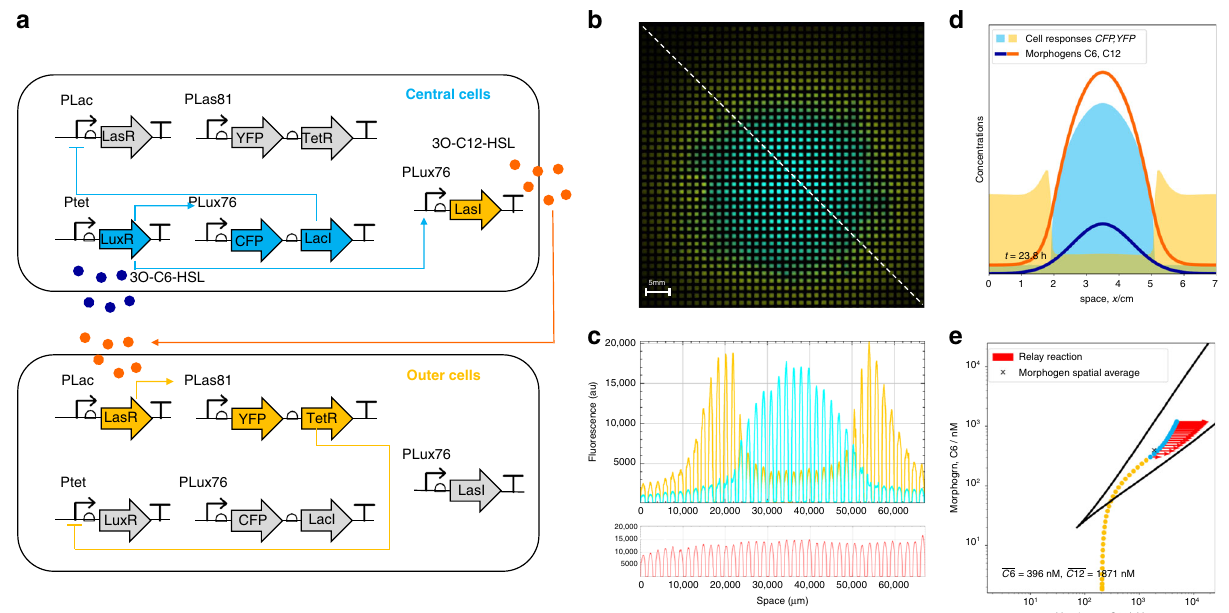
Fig. 4 Addition of a relay circuit creates self-organised domains of gene expression. a Circuit diagram of Exclusive Receiver cells co-transformed with a Relay circuit (P76-LasI) that responds to C6 by producing C12. b Isogenic cells transformed with the circuit shown in a and grown for 24 h in the presence of a gradient of C6 diffusing from the centre. Cells that experience high levels of C6 (central cells) will express CFP, LacI, and LasI, causing them to produce C12 but be unable to sense it. Neighbouring cells (outer cells) that do not experience C6 will sense C12 and express YFP and TetR, resulting in mutually exclusive domains of gene expression. Cells also constitutively express mRFP1 via a genomic transgene. Image is representative of 3 biological replicates performed on 3 different days. c Quantitation of fl uorescence along the dotted line in b . Cyan, yellow, and red indicate CFP, YFP, and RFP expression, respectively. d Final timepoint of simulation shows a secondary gradient of C12 (orange) produced in response to the primary C6 gradient (dark blue). Cyan and yellow indicate simulated CFP and YFP expression, respectively. e Final time point of simulation in C6-C12 space labelling points in physical space by their CFP and YFP expression (cyan and yellow points), and showing the production of C12 as vectors (red arrows) that move the spatial average (x) toward increasing C12 (see supplementary video